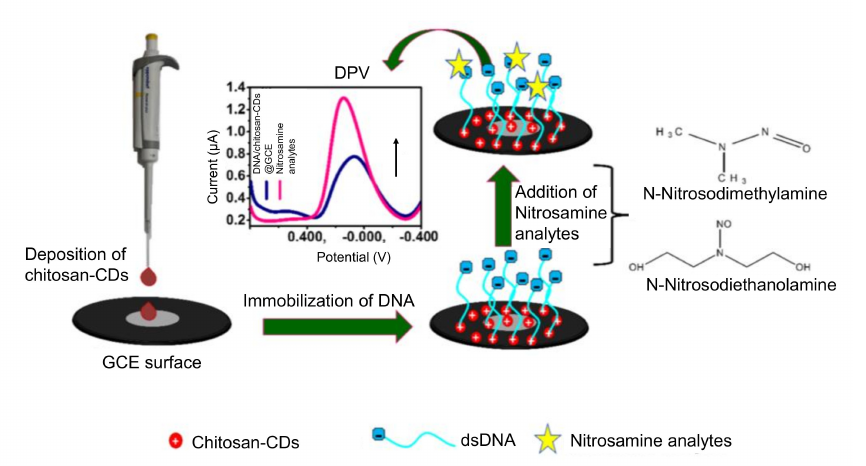
Figure 14. Steps involved in the construction of a chitosan-CDs based electrochemical DNA sensor for the detection of mutagenic nitrosamines. Reprinted from [212], with permission from American Chemical Society,